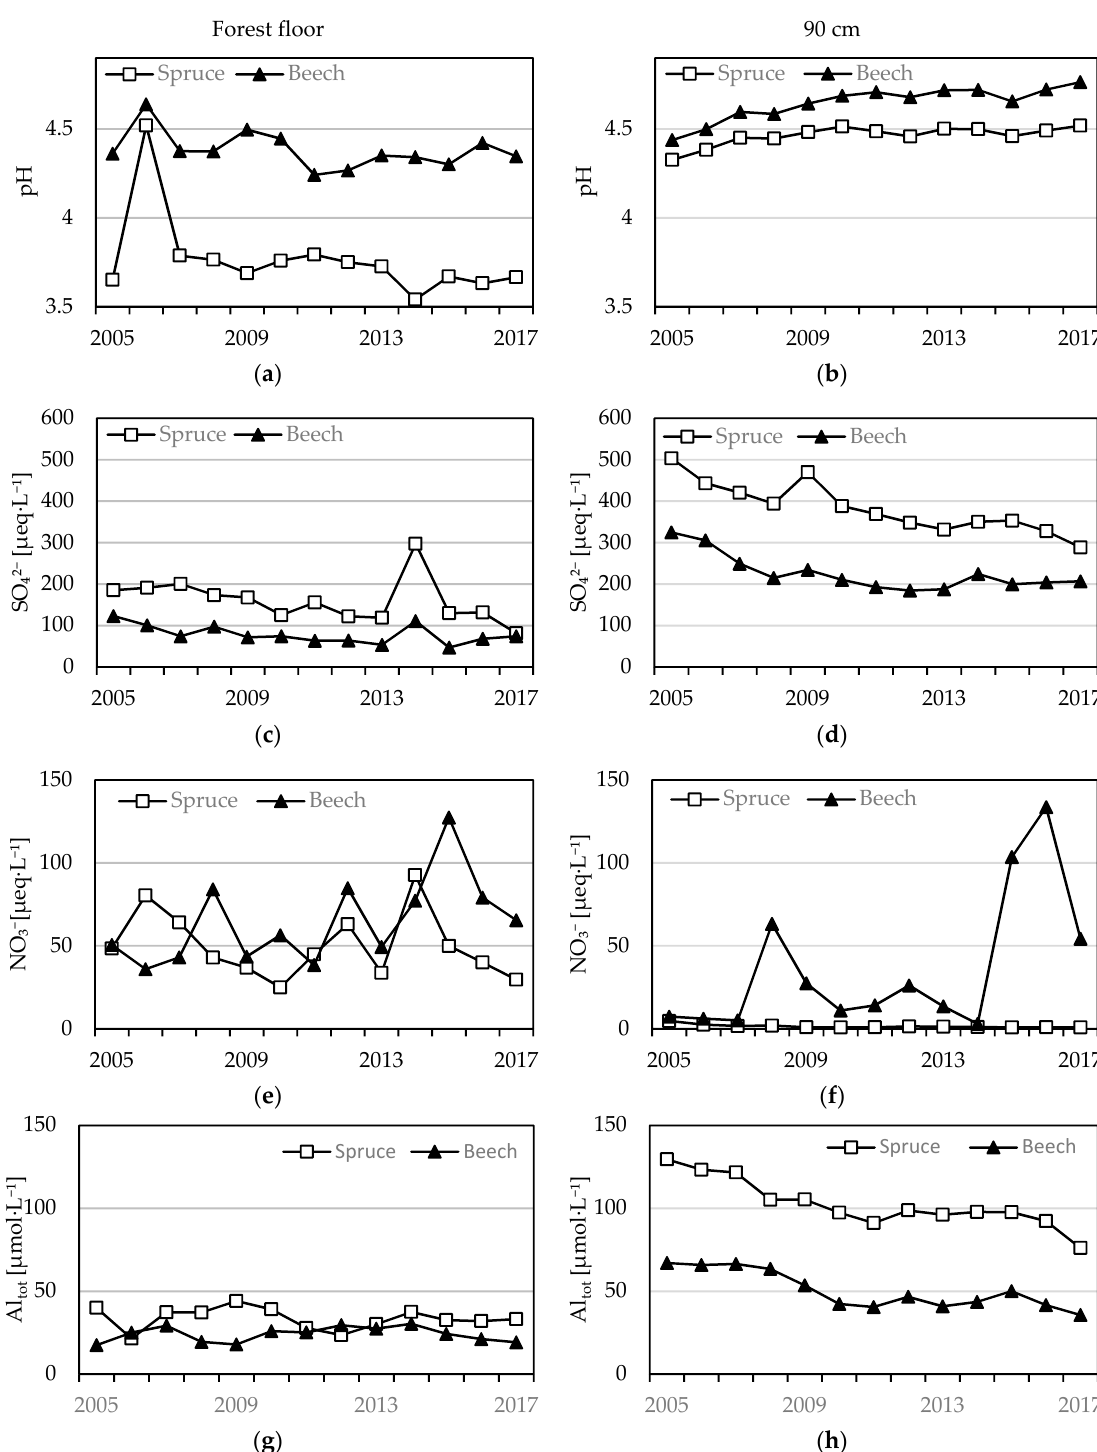
Figure 2. Mean annual pH, SO 42- , NO 3- , and total Al (Al tot ) concentrations from forest floor (left – a , c , e , g ) and 90 cm (right – b , d , f , h ) horizons of beech and spruce soil solutions.